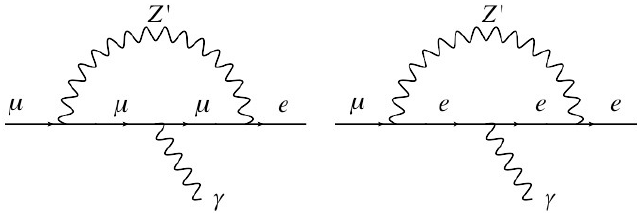
Figure 2 . One loop diagrams inducing (cid:22) ! e(cid:13)